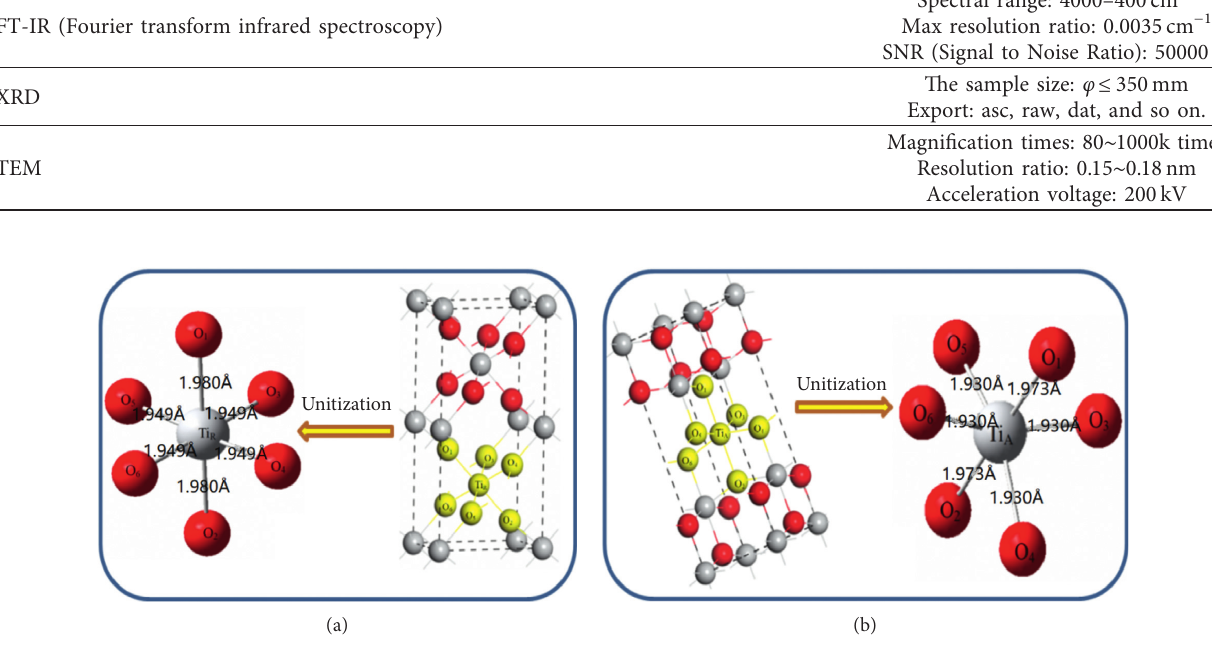
Figure 1: The structural model of TiO 2 ; (a) the structural model of rutile; (b) the structural model of anatase.